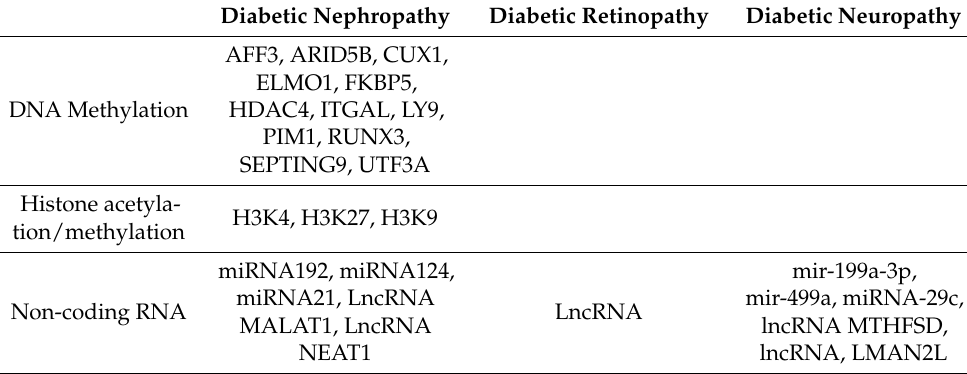
Table 1. Specific epigenetic modifications in T2D